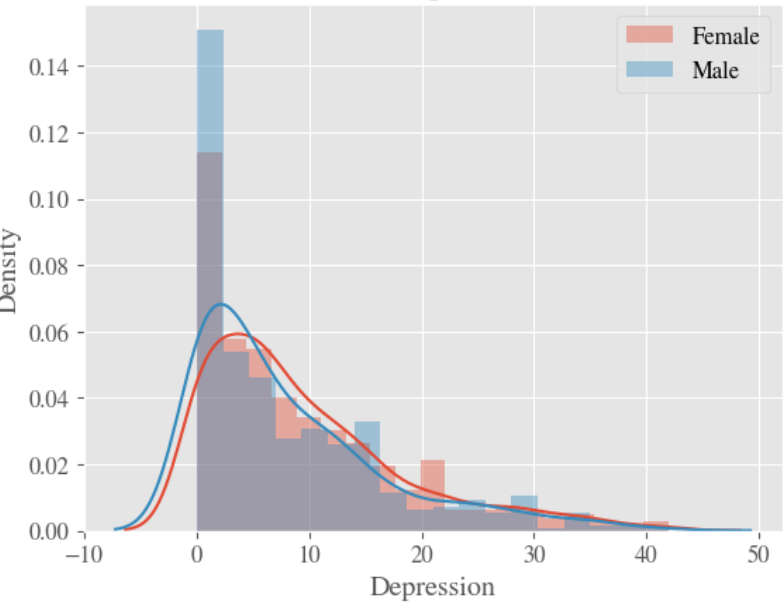
Figure 2. The Distribution of Levels of Depression in Men and Women.